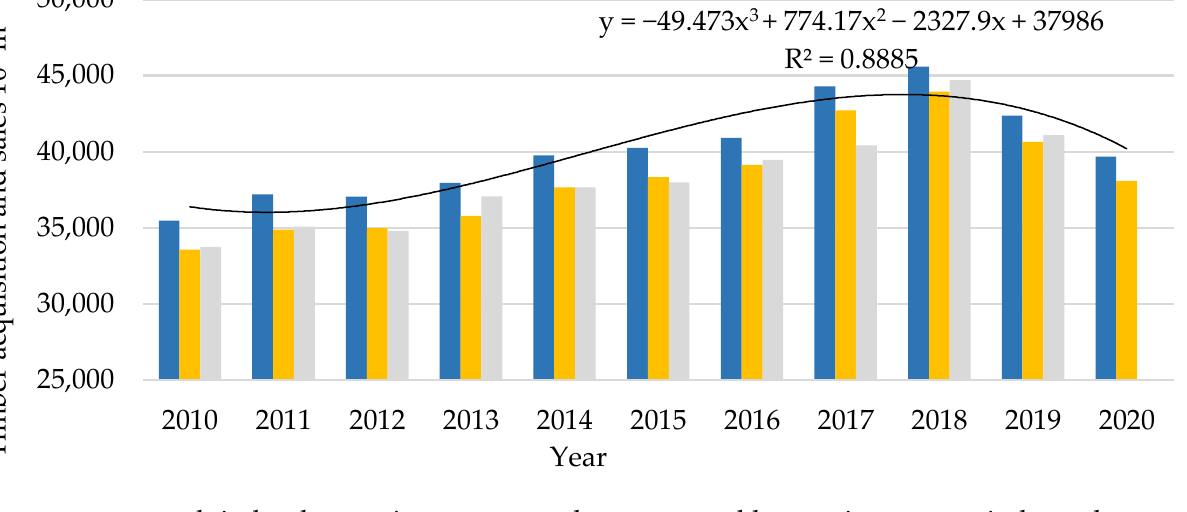
Figure 4. Acquisition of wood. Source: own elaboration based on Statistical Yearbooks of Polish Forestry Source [30,31]; own elaboration based on the available publications.